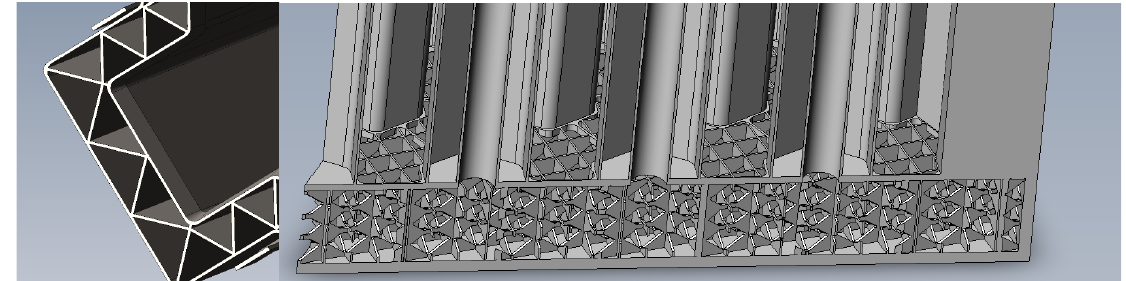
Figure 1. Samples of structures minimalized to maintain performance and reduce material